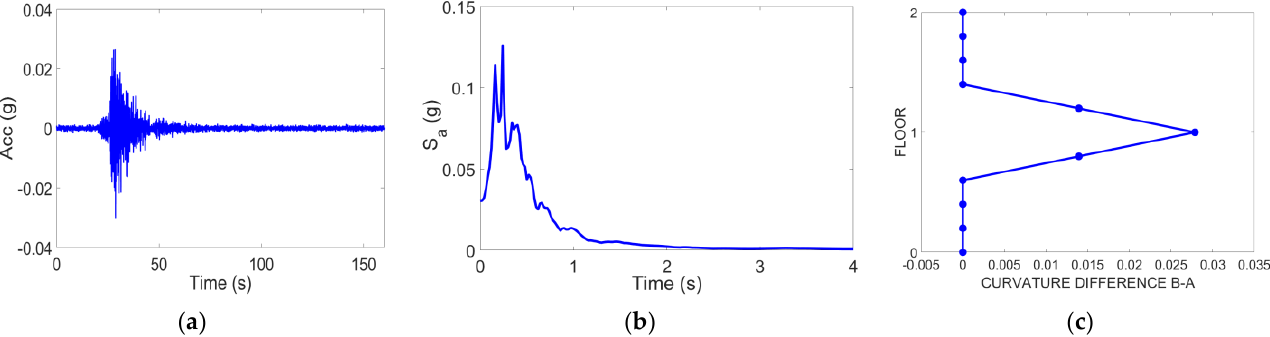
Figure 22. Accelerometric recordings at the different floors of the Navelli municipality building along the transversal direction.